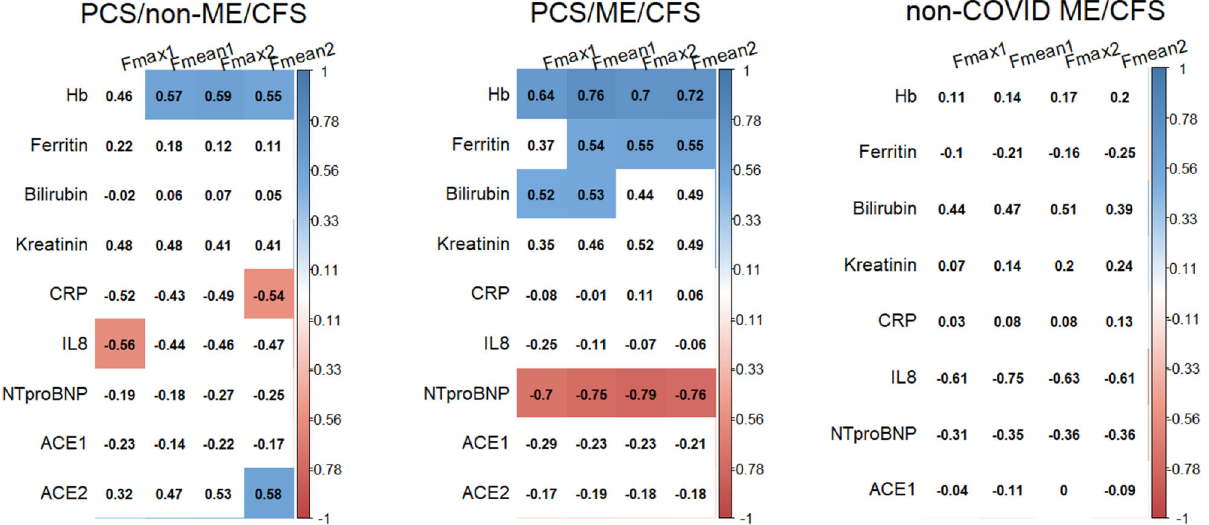
peptide; ACE angiotensin converting enzyme; HGS hand grip strength. Correlation of HGSparameterFmax1, Fmean1,Fmax2,and Fmean2withlaboratoryparameters ofrelevanceforoxygensupply,in fl ammation,andvasoregulation.Weanalyzedthe data within a correlation analysis using spearman ’ s ρ and Benjamini-Hochberg (BH)correction for multiplicity. Correlations that were signi fi cant are indicated by blue (positive) or red (negative). Source data are provided as a Source Data fi